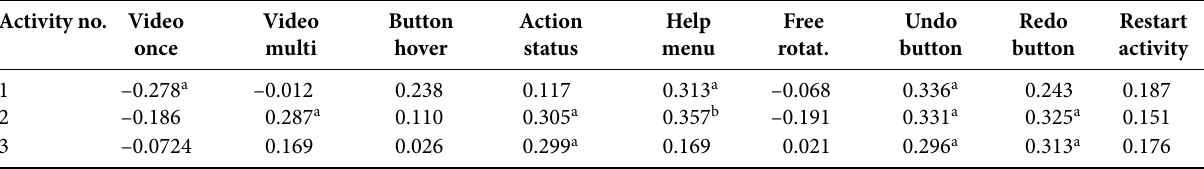
Table 16: Spearman correlations between actions with help tools and step difficulty mean Activity no.